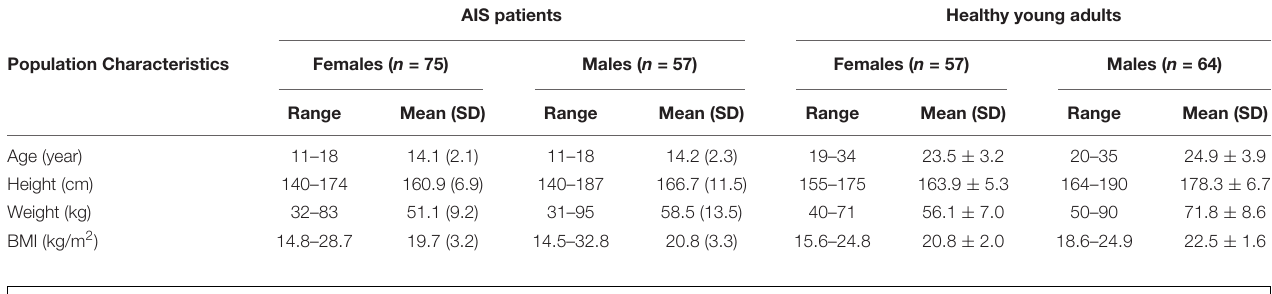
TABLE 1 | Sample population characteristics: Total of 132 adolescent idiopathic scoliosis (AIS) patients and 121 healthy young adults.